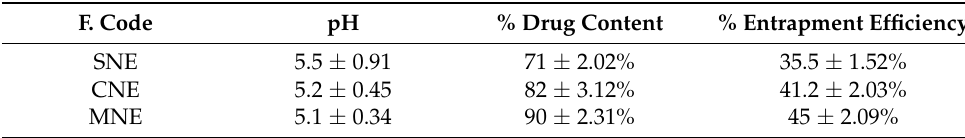
Table 3. pH, drug content and %EE of formulations.